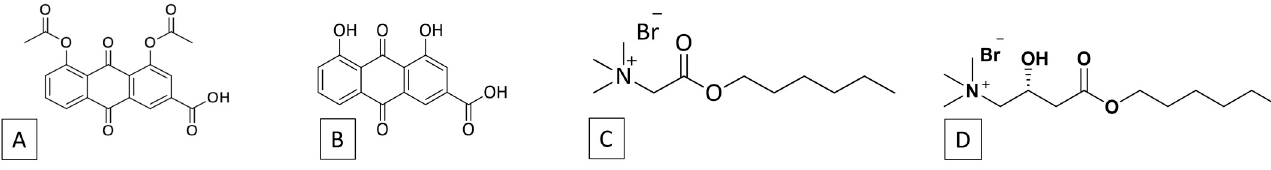
Figure 1. Chemical structures of active compounds and ILs applied in the study: ( A ) diacerein (DIA); ( B ) rhein (Rhe), the hydrolysed metabolite of DIA; ( C ) (2-hexyloxy-2-oxoethyl)-trimethylammonium bromide, Bet6 IL; ( D ) (R)-(4-hexyloxy-2-hydroxy-4-oxobutyl)-trimethylammonium bromide, Carn6 IL.